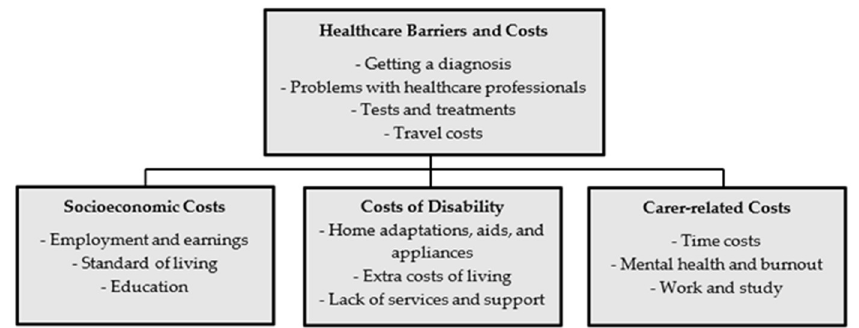
Figure 2. Economic impact of myalgic encephalomyelitis/chronic fatigue syndrome (ME/CFS) [29].